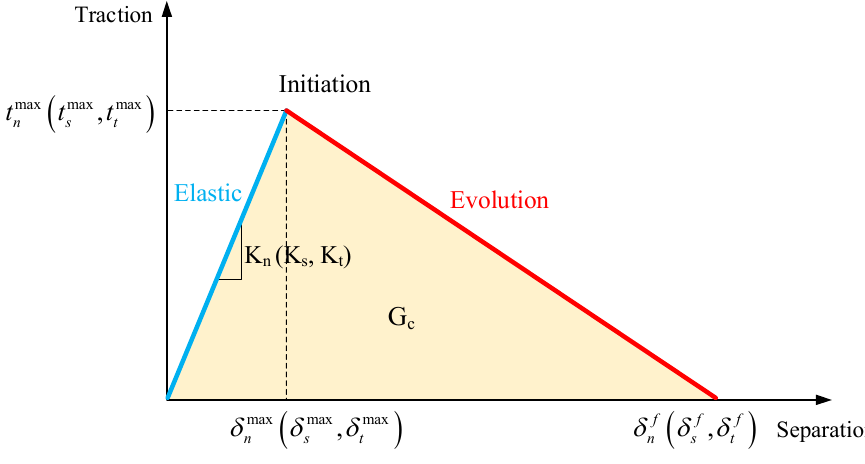
Figure 10. Traction-separation relationship.